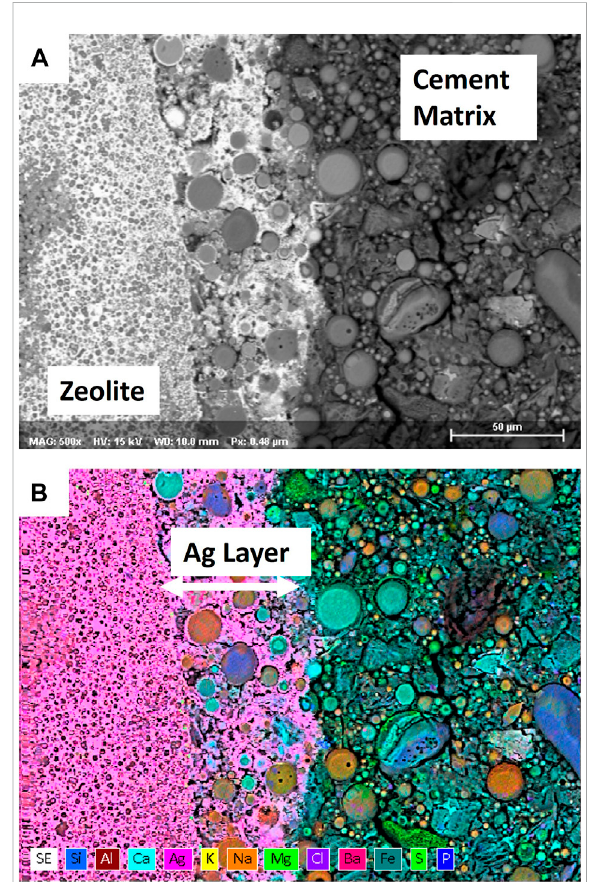
FIGURE 5 Scanning Electron Microscopy (SEM) micrograph (A) and corresponding Energy Dispersive X-ray Spectroscopy (EDS) map color map (B) of an Ag-enriched region between an Ag-zeolite particle that had been encapsulated in a cementitious matrix. Samples were prepared in a method similar to the method described in (Yamagata et al.,